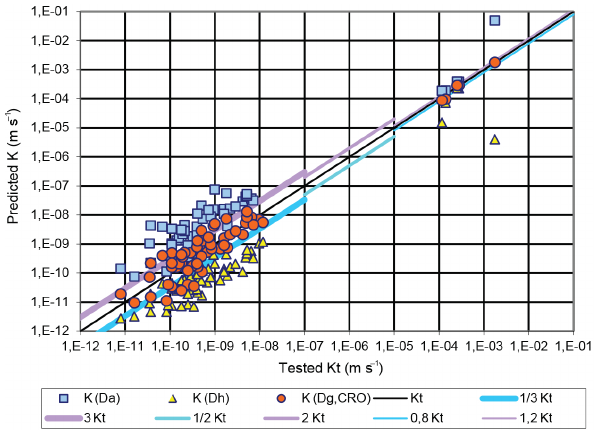
Figure 13. Relation between of effects of mean grain size D a , D g and D h on predicted hydraulic conductivity for all analyzed sam- ples.